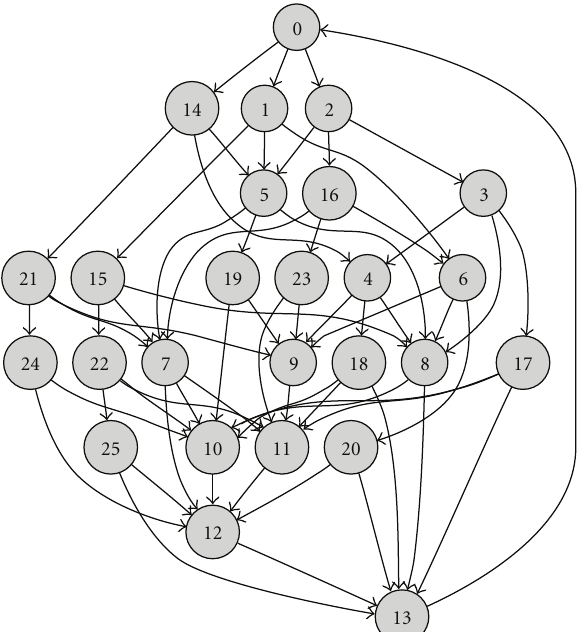
Figure 6: Example of a generated configuration call graph.